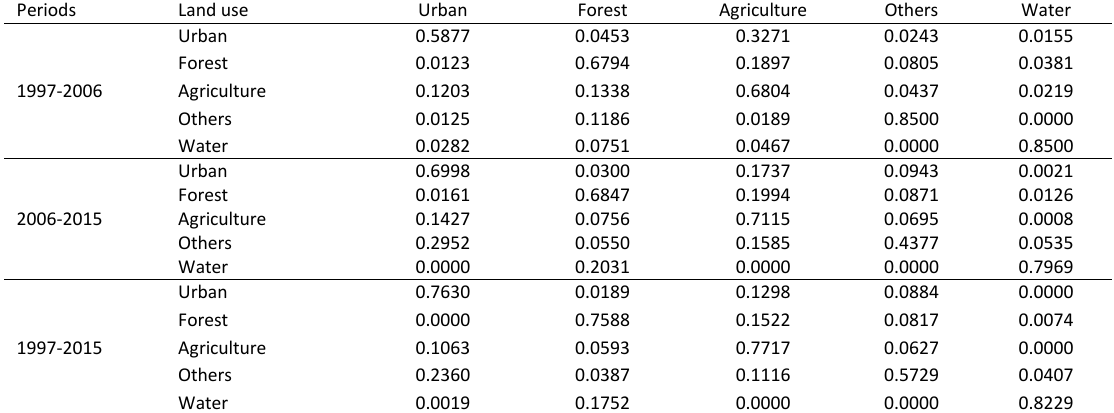
Table 2: Transition probability matrices of time periods of 1997-2006, 2006-2015, 1997-2015 Periods